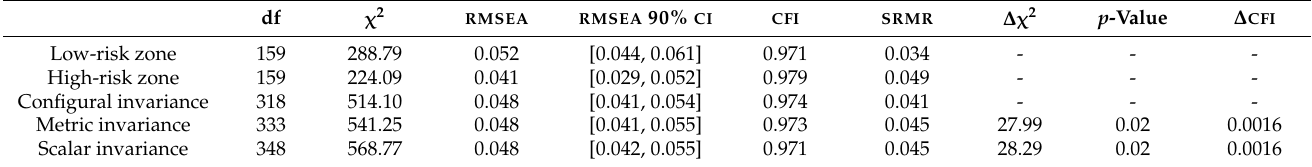
Table 6. SAPH@W invariance across risk zone: model fit.